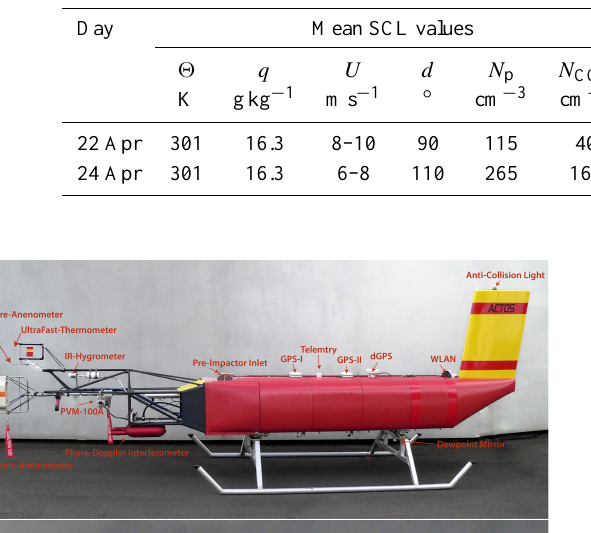
Table 2. Summary of mean SCL and in-cloud parameters for April 22 and April 24.